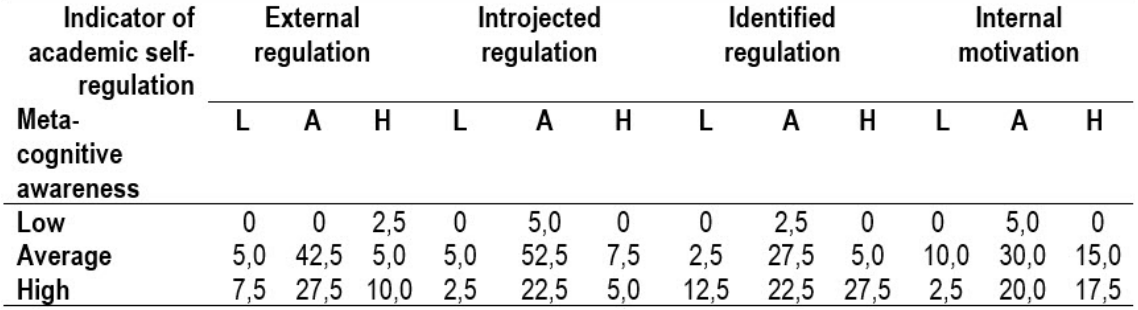
Indicators of correlation between the levels of metacognitive awareness and motivation of self- regulated learning of students,